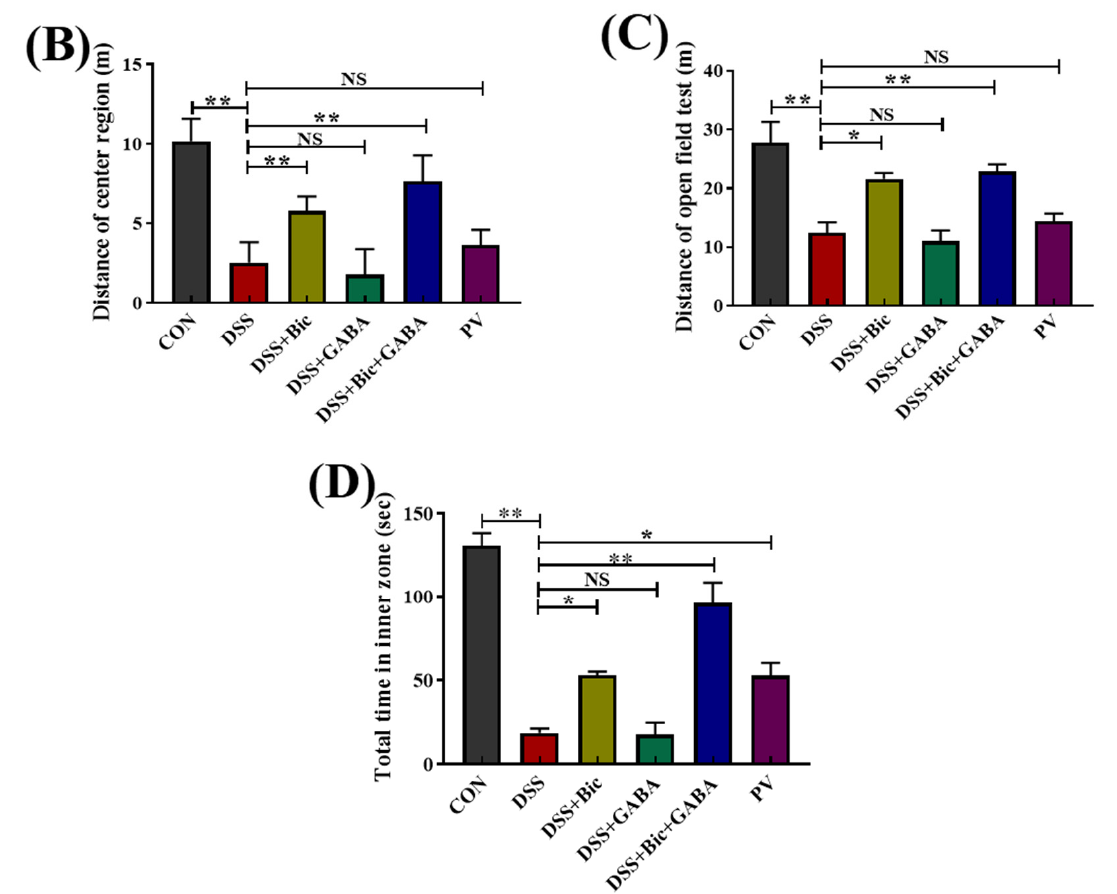
Figure 5. Behavior test of mice in each group. ( A ) Activity tracks from representative mice in an open field during a 5 min recording time. The blue dot represents the start of the track, and the red dot represents the end of the track. ( B ) Distance traveled in the center region. ( C ) Total distance traveled. ( D ) Time spent in the center region. Data are presented as mean ± SEM ( n = 10 per group). * p < 0.05, ** p < 0.01. NS indicates no significant change.